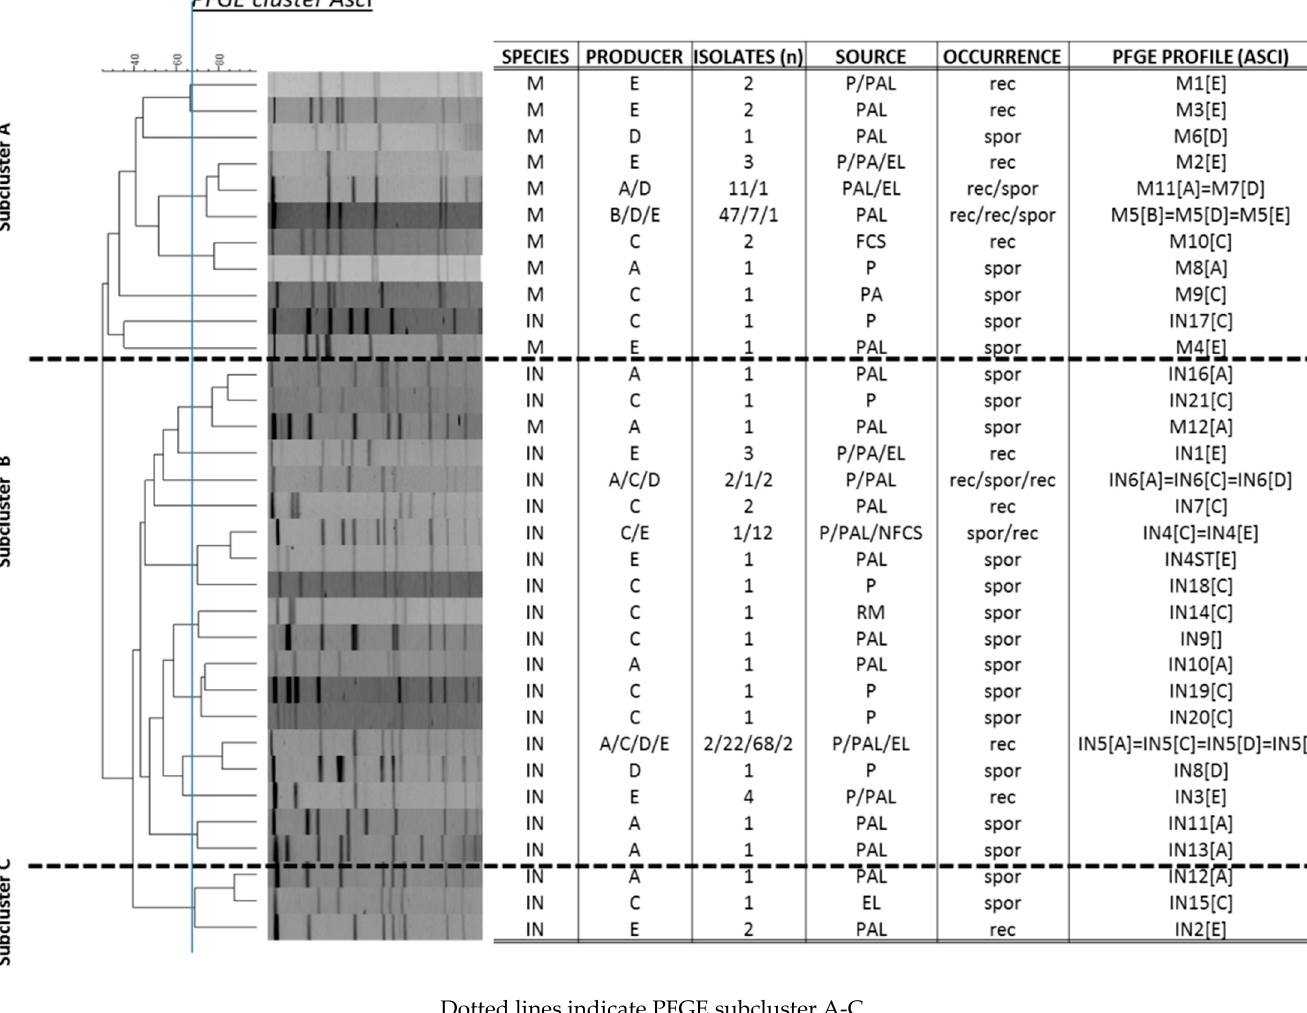
Dotted lines indicate PFGE subcluster A-C. Figure 1. PFGE cluster analysis ( Asc I) of L. innocua ( n = 139) and L. monocytogenes ( n = 81) isolates included in this